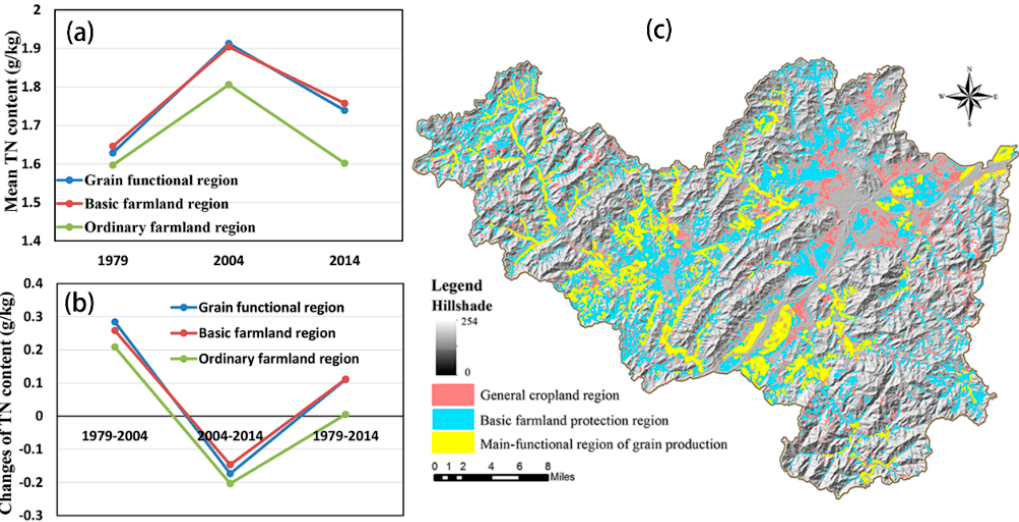
Figure 8. The average TN ( a ) and the changes in TN ( b ) in three farmland regions ( c ) were also analyzed in the present study to further understand the effects of land management on the spatiotemporal distributions of soil TN in cultivated lands.